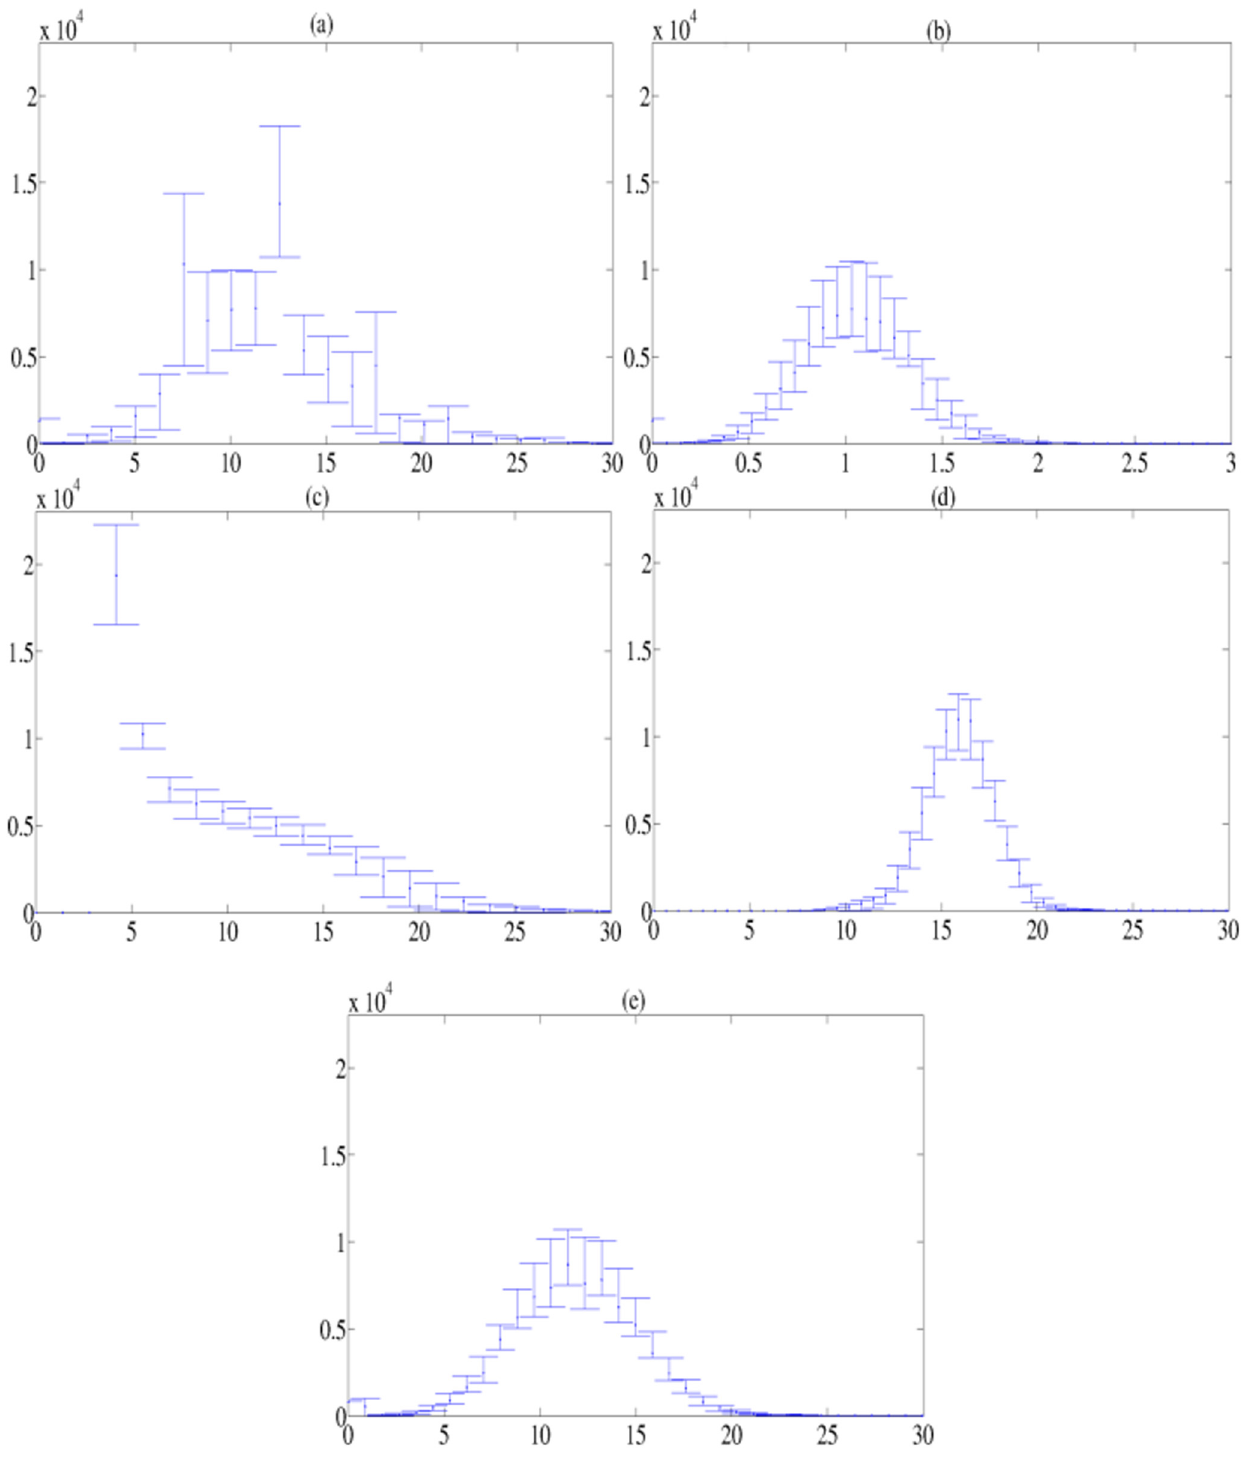
Fig 5. Mean histograms and error bars in the non-specific region for 127 DaTSCAN images before and after intensity normalization. (a): Original DaTSCAN images, (b): BR all images, (c): FGMM images, (d): MSE images and (e) α -stable images. The x-axis represents the intensity. The y-axis indicates the number of voxels with a given level in the non-specific